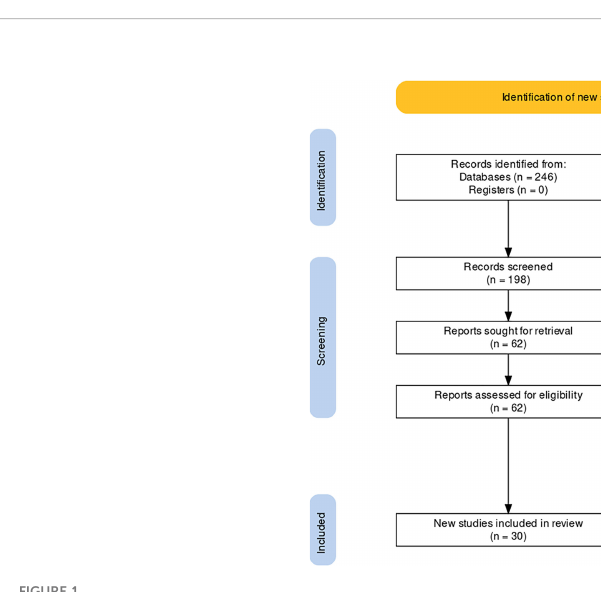
FIGURE 1 PRISMA 2020 fl owchart for study